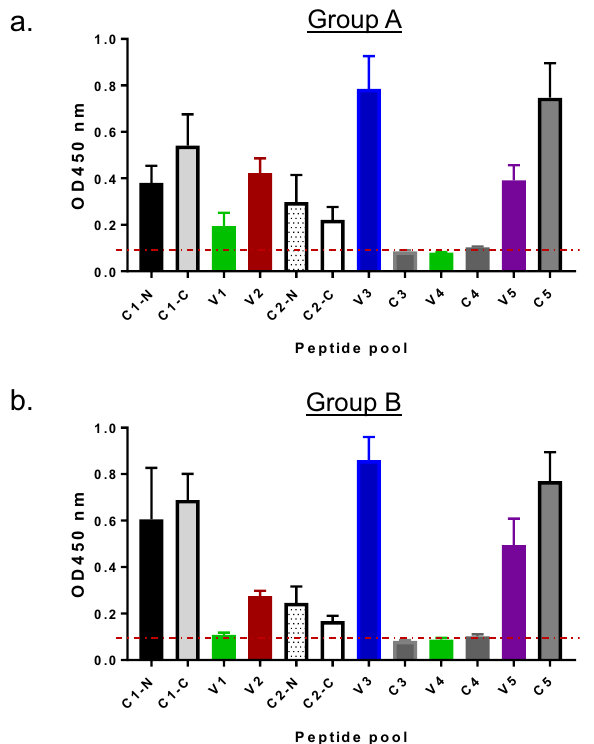
Fig. 2 ELISA mapping of IgG responses in DP6-001 vaccinee sera (at 1:1000 dilution) against pooled overlapping peptides from different regions of Group B consensus gp120. Each bar represents the mean OD value of sera from either Group A (Panel a ) or Group B (Panel b ).